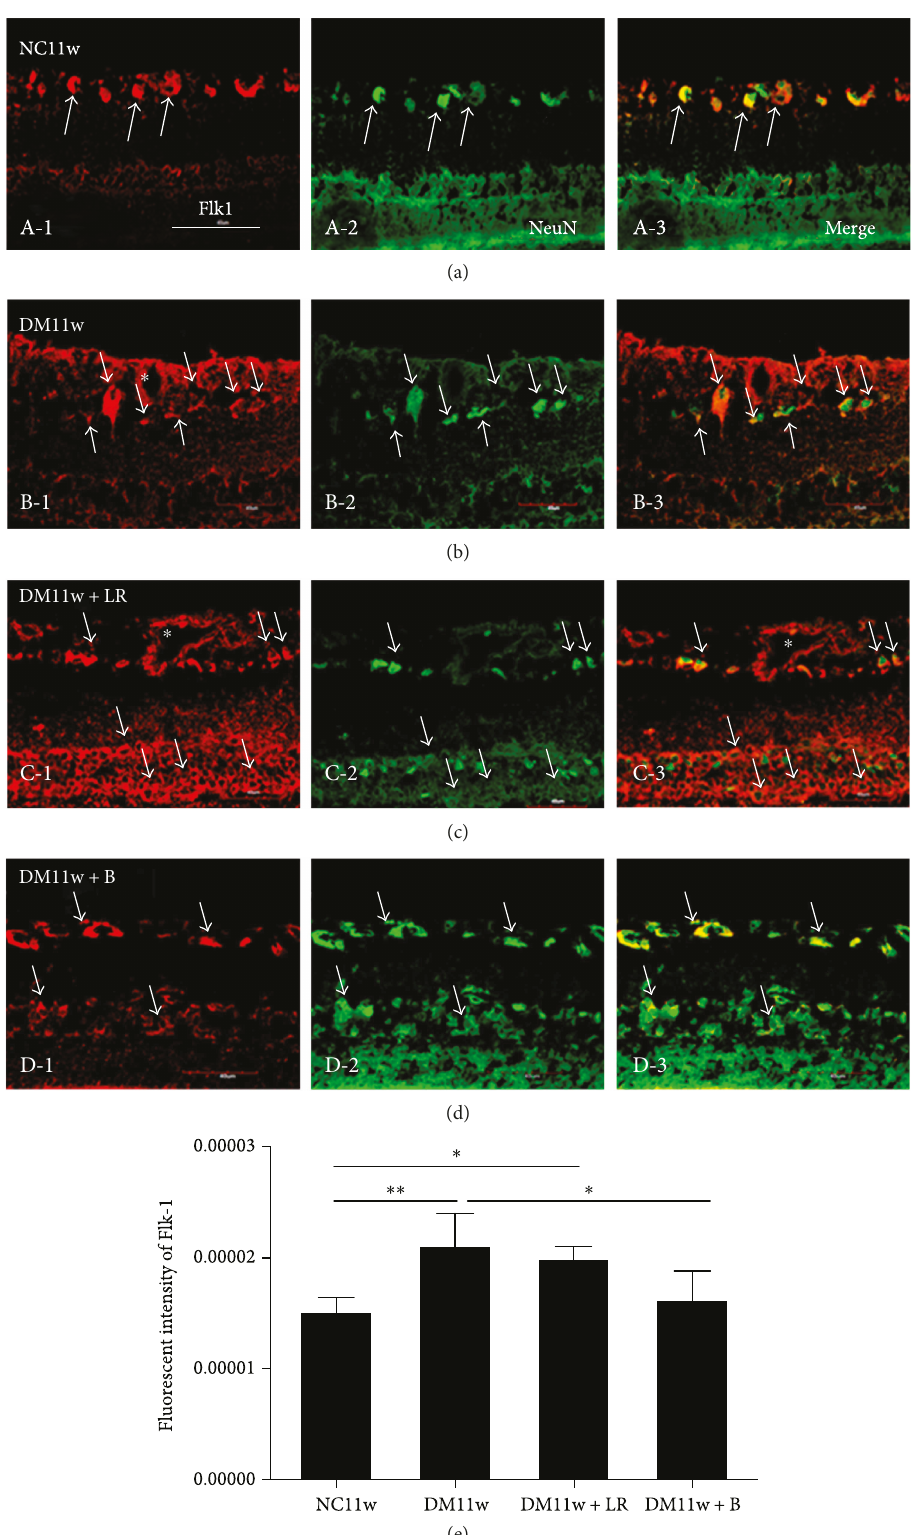
Figure 8: Representative photomicrographs of Flk-1 (red) and NeuN (green) double staining of the retina in the NC11w, DM11w, DM11w +LR, and DM11w+B groups. (a, b, c, D-1) Flk-1 immunoreactivity appeared to maintain its structural integrity and to be lower in the NC11w and NC11w +B groups (single arrow). (e) Semiquanti fi cation of Flk-1 by immuno fl uorescence. Note the dilated blood vessels in diabetic retina at the DM11w and DM11w+ LR (asterisk). Bar=50 μ m. ∗ p < 0 05 and ∗∗ p < 0 01